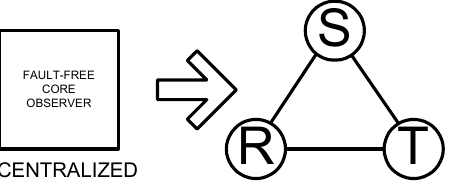
Figure 1. The Ptolemaic Universe triad-based ReSeT model.